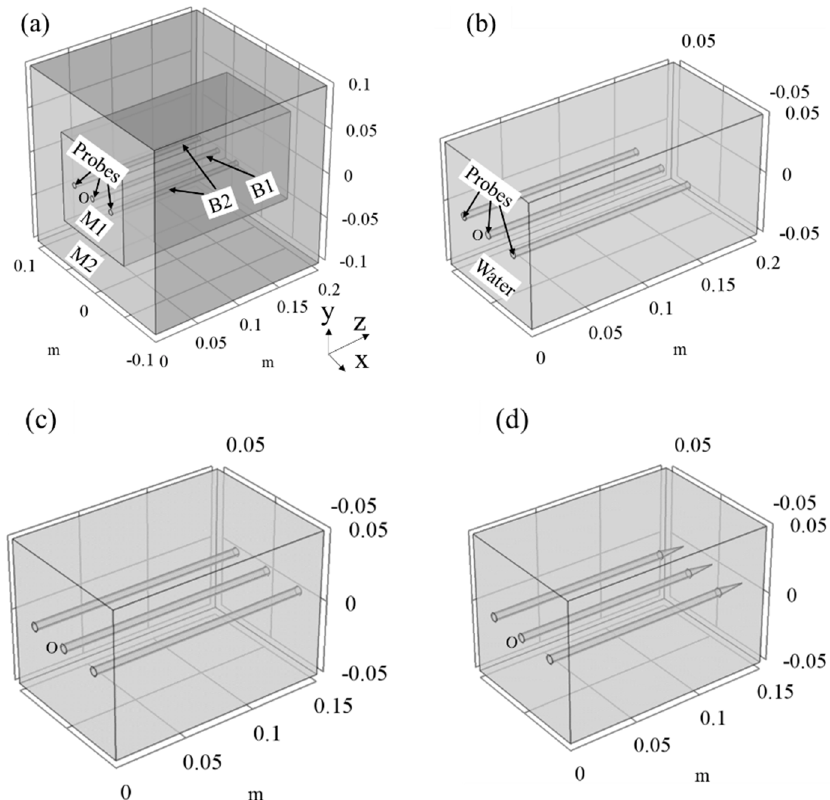
Figure 5. Models used for numerical computation at the initial state for the horizontal probe. ( a ) N1: Air surrounding the water medium; ( b ) N2: Initial water zone with box size; ( c ) N3: Initial water zone with a length the same as that of the probe; ( d ) N4: initial water zone with a length the same as that of the probe and sharp probe end. ( b – d ) have the same coordinates as ( a ). The unit of the dimensions of the model is m.